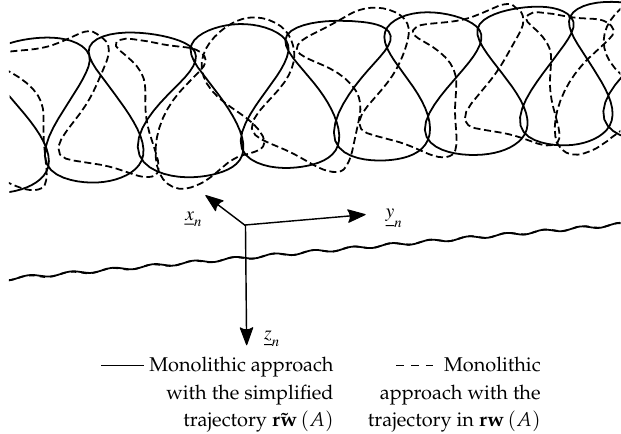
Figure 13. Kite and ship path with respect to n for L t = 390 m with a wave of 2.5 m high at the frequency ω w = 0.8 rad.s − 1